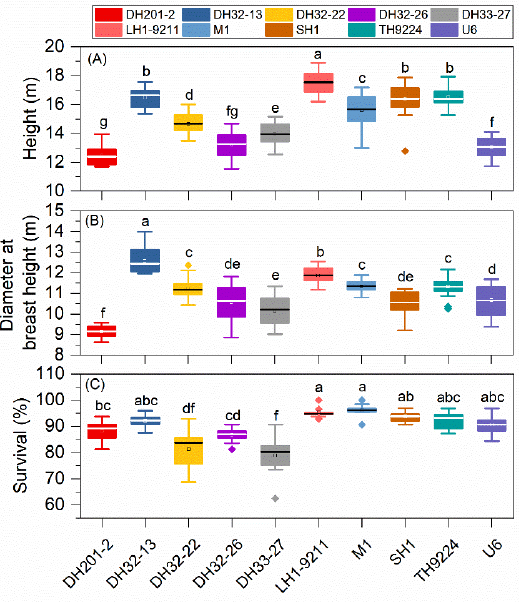
Figure 2. Growth performance of ten Eucalyptus Clones. Significant differences within each variable among clones were tested using Tukey’s HSD test (0.05 level); different small letters denote differences in means among clones. ( A ) Height, ( B ) diameter at breast height, ( C ) survival.